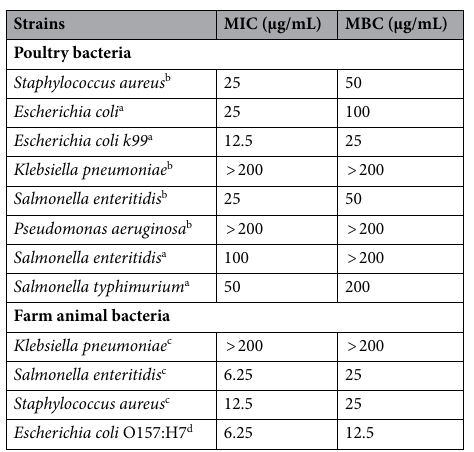
Table 1. Comparative MIC and MBC of the thanatin in various Gram-positive and negative bacteria. Data are collected as MICs according to the CLSI (www: clsi.org). All bacteria were obtained from Mashhad School of Veterinary Medicine Collection, Ferdowsi University of Mashhad, Iran. ND not determined. a From poultry diarrhea. b From poultry intestine infection. c From cattle mastitis. d From calf